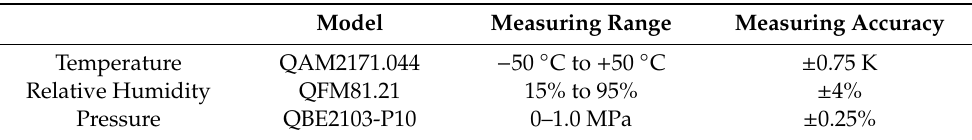
Figure 7. HVAC systems: ( a ) Case building AHU and ( b ) Monitoring and operation system. Table 3. Sensors mounted in the AHU.